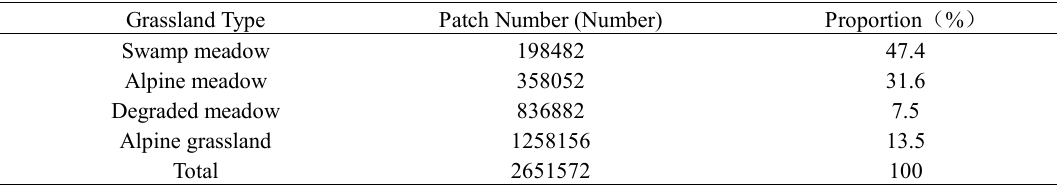
Table 2. Statistical table of the number of patches on the Qinghai-Tibet plateau